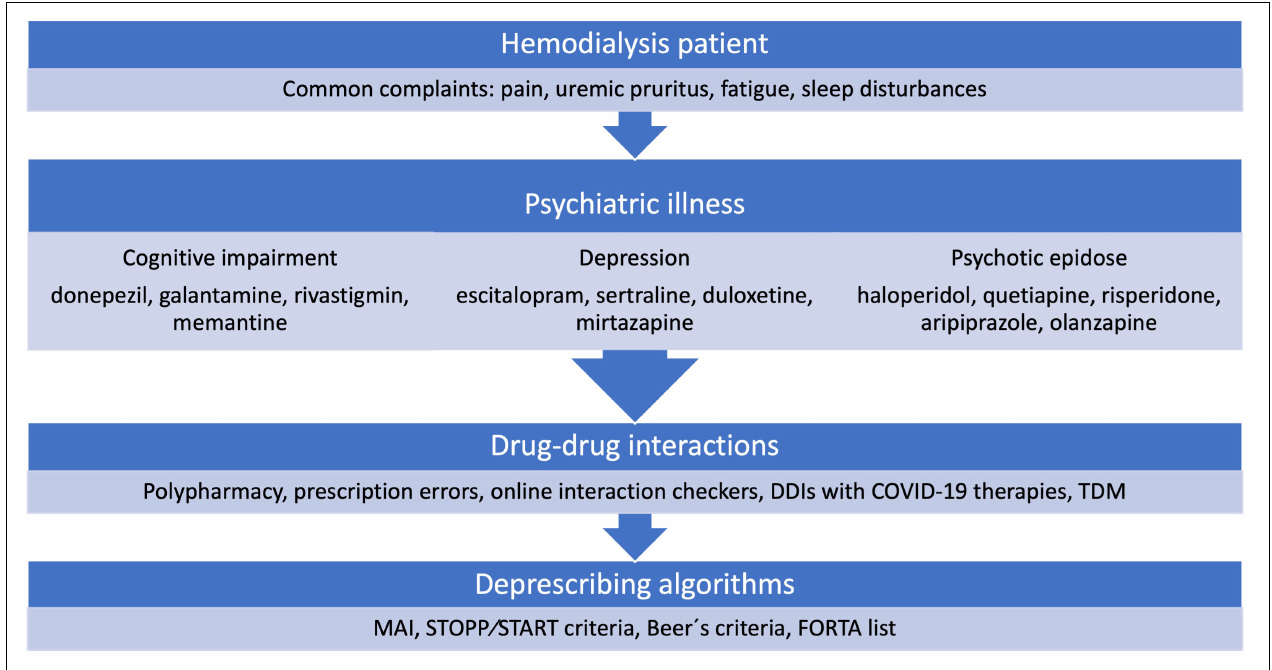
FIGURE 1 | Overview of the covered topics. DDIs, drug-drug interactions; TDM, therapeutic drug monitoring; MAI, Medication Appropriateness Index; STOPP/START, Screening Tool of Older Persons Prescriptions and Screening Tool to Alert doctors to Right Treatment; FORTA, Fit-fOR-The-Aged.